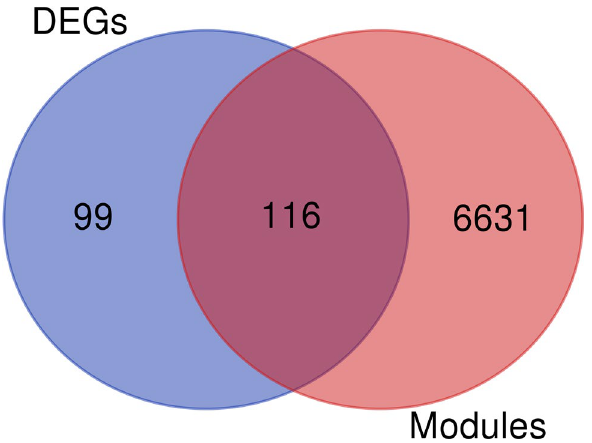
Figure 6. The Venn diagram representing the number of DEGs selected by the meta-analysis and the number of genes selected by the significant modules in the weighted co-expression analysis.